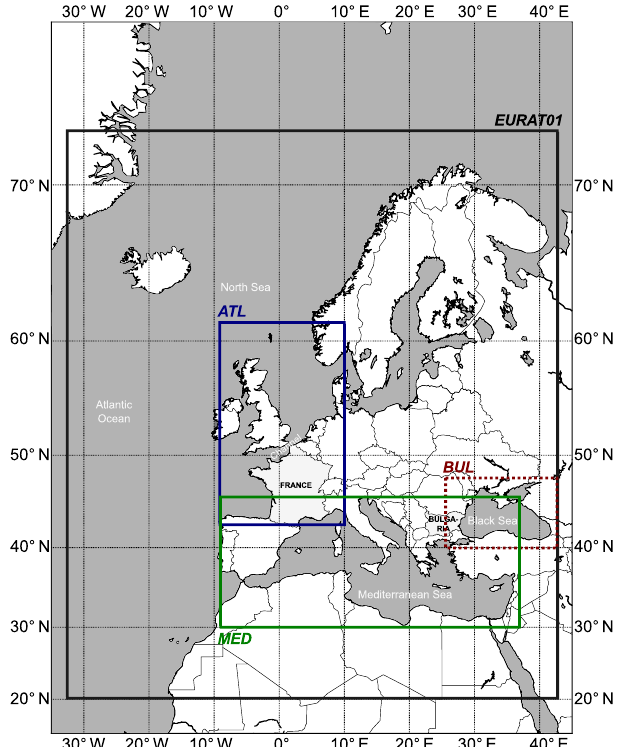
Figure 2. Locations of EURAT01 (black), ATL (blue), MED (green) and BUL (red) domains used in the study, respectively, for European 0.1 ◦ resolution grid and Atlantic, Mediterranean and Bul- garian